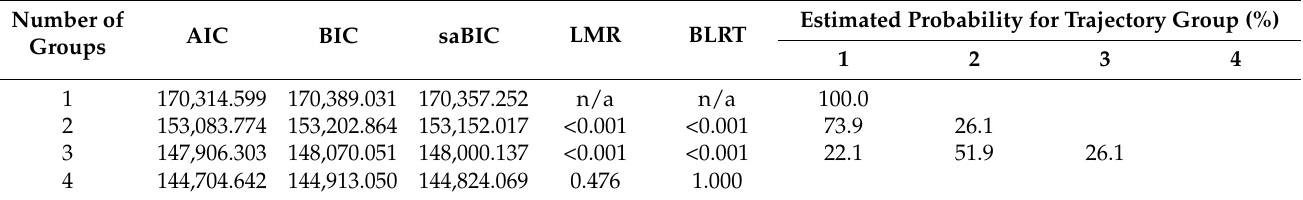
Table 3. Fit indices of latent class analysis and distribution rate of health behavior due to COVID-19.